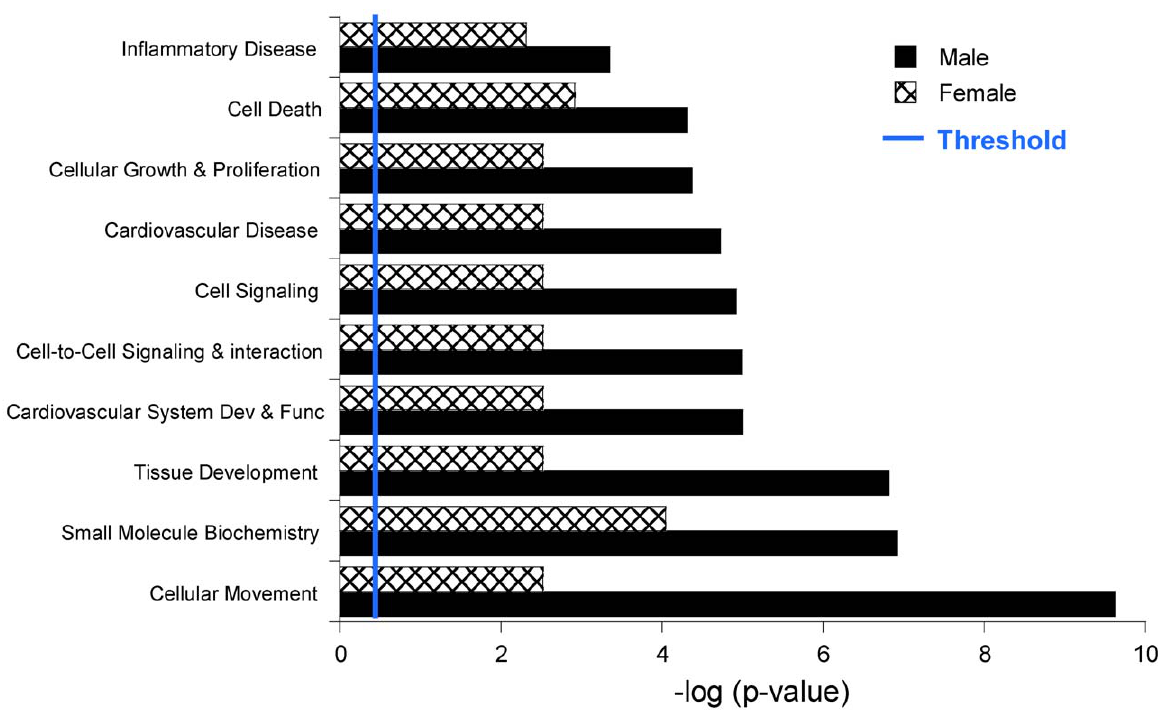
Figure 2. Functional categorization analysis of most significant pathways and diseases represented by microarray data. A functional categorization analysis of the most significant pathways and diseases represented in the microarray-generated list of significantly different genes was generated using Ingenuity software. The p-value was calculated using the right-tailed Fisher’s exact test. Each bar represents the highest level of function for each category, each of which includes many sub-level functions and is represented by the number of genes in the male and female samples (denoted in parentheses, respectively). The bar was determined by the lowest p-value among sub-level functions for each category. Threshold indicates p-value cutoff of 0.05.